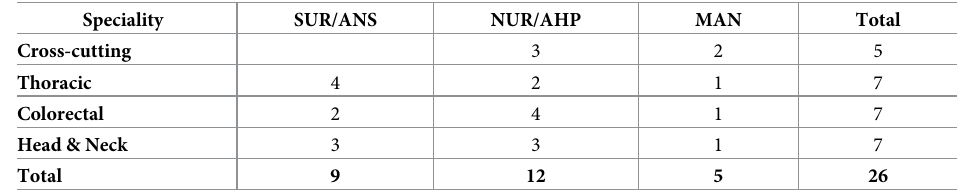
Table 2. Health care professionals